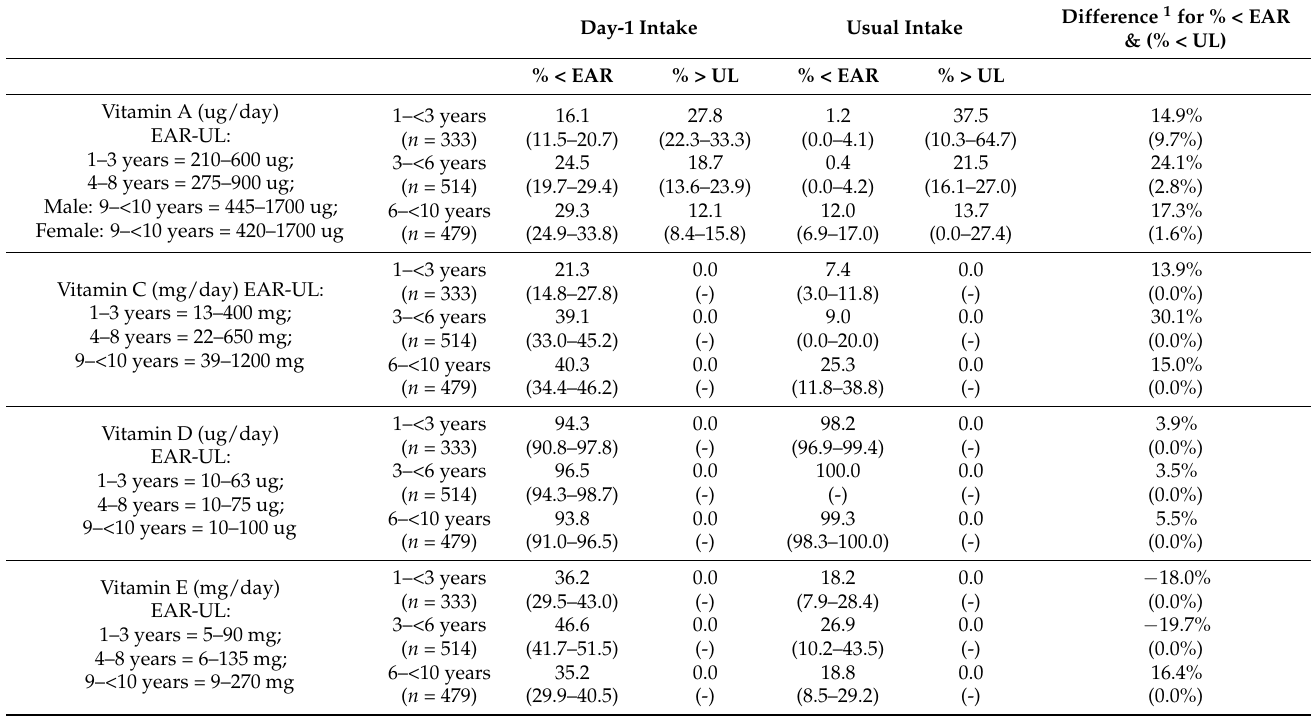
Table 7. Comparison of percentage below EAR and above UL cut-points for risk of vitamins A, D, E and C deficiency and excess respectively, by age group.